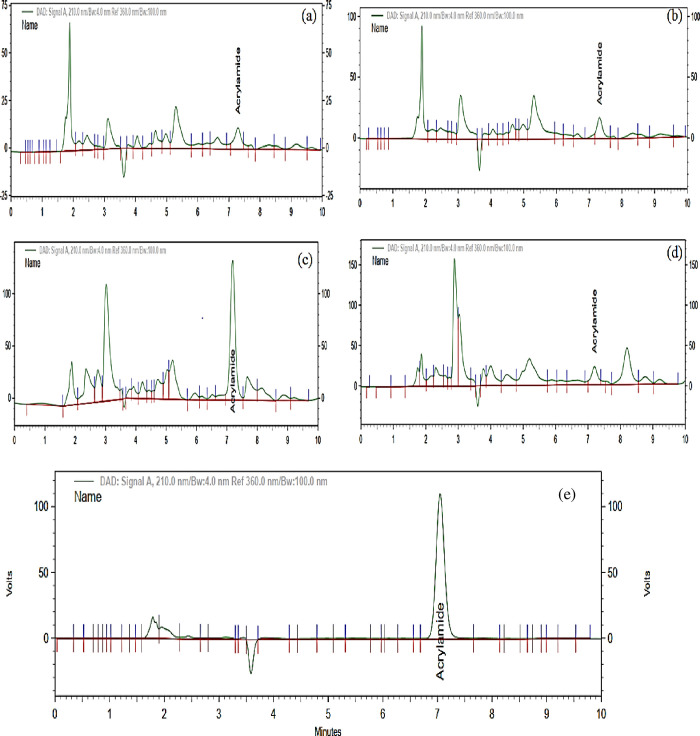
Chromatogram representation of acrylamide for different roasting condition.a) light roasted coffee; b) medium roasted coffee; c) medium dark roasted coffee; d) dark roasted coffee; e) standard.